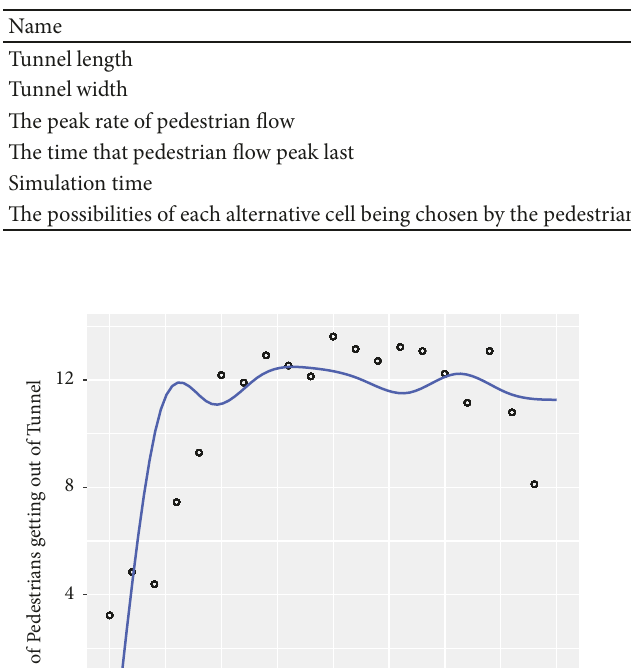
Table 3: Parameters of the simulation.